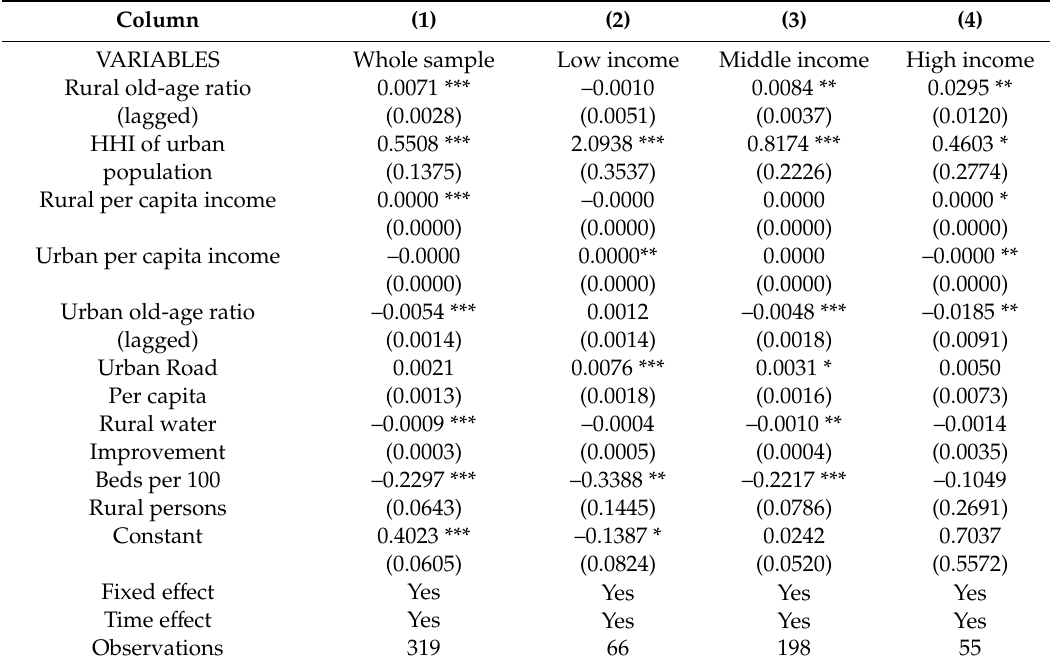
Table 3. Rural old-age ratio and the concentration of urban inpatient visits